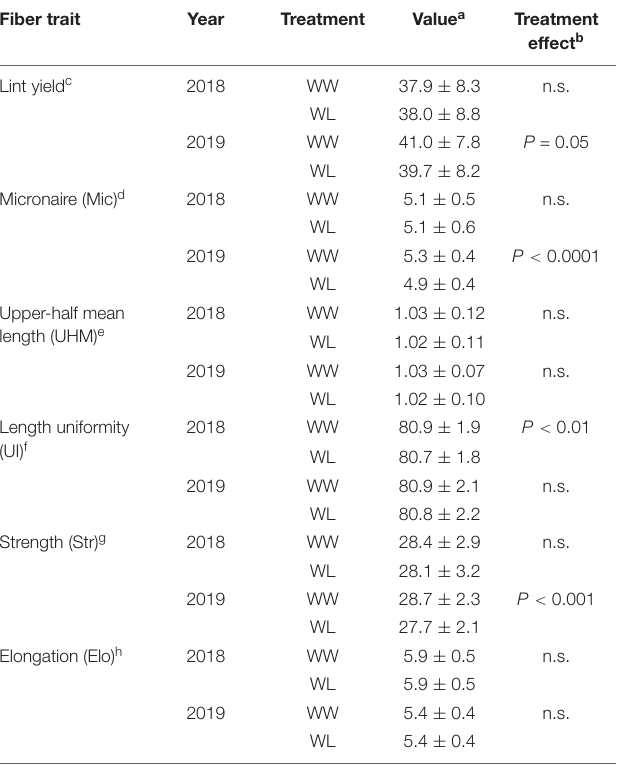
TABLE 1 | Fiber traits evaluated under well-watered (WW) and water-limited (WL) conditions in 2018 and 2019 in the 22 cotton accessions. Fiber trait Year